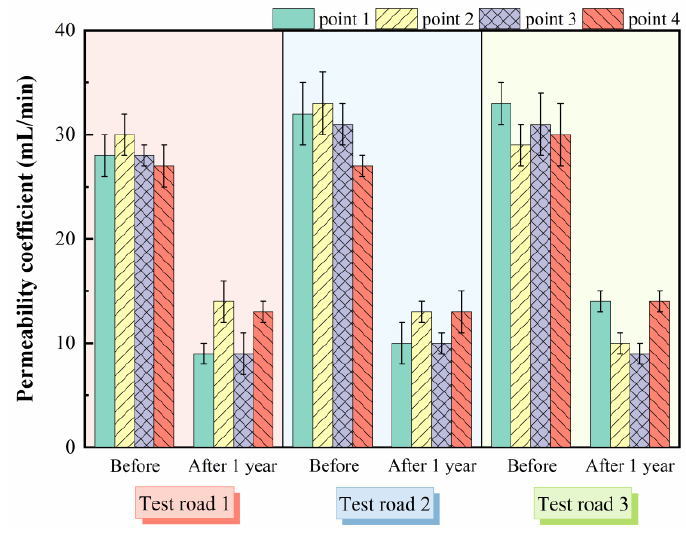
Figure 13. Permeability test results before and after operation of the test roads.